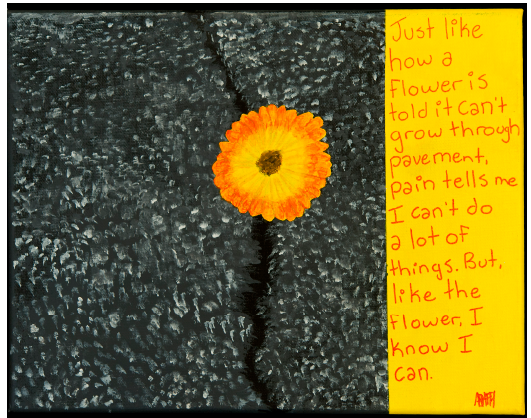
Figure 2. “A flower can grow” created by a Pain 101 participant, A.F.H.